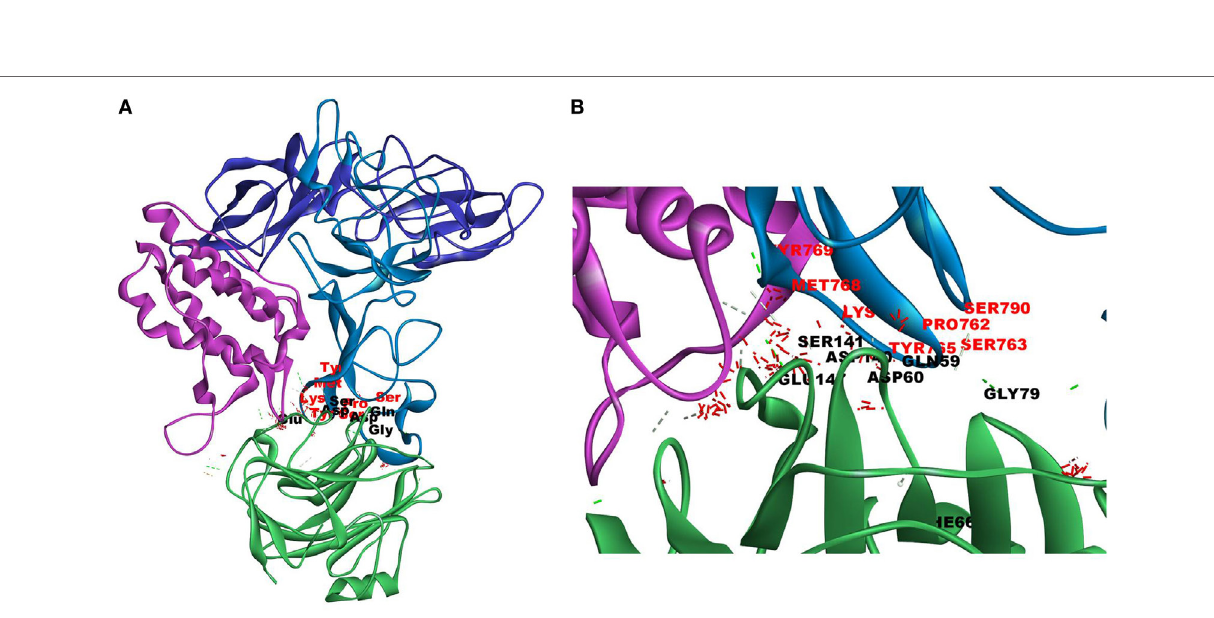
FigUre 3 | Docking of C-reactive protein (CRP) to modeled leptin receptor. Protein–protein docking was done between modeled leptin receptor (CRH2–FNIII) and CRP (monomer) (PDB Id 1GNH) as described in Figure 1 . The image of the pose with the best Z -rank score in the largest cluster is shown in (a) leptin receptor modeled [CRH2 (deep blue) –Fn III domains (light blue)] docked with CRP monomer (green) and (B) enlarged image of docked amino acid